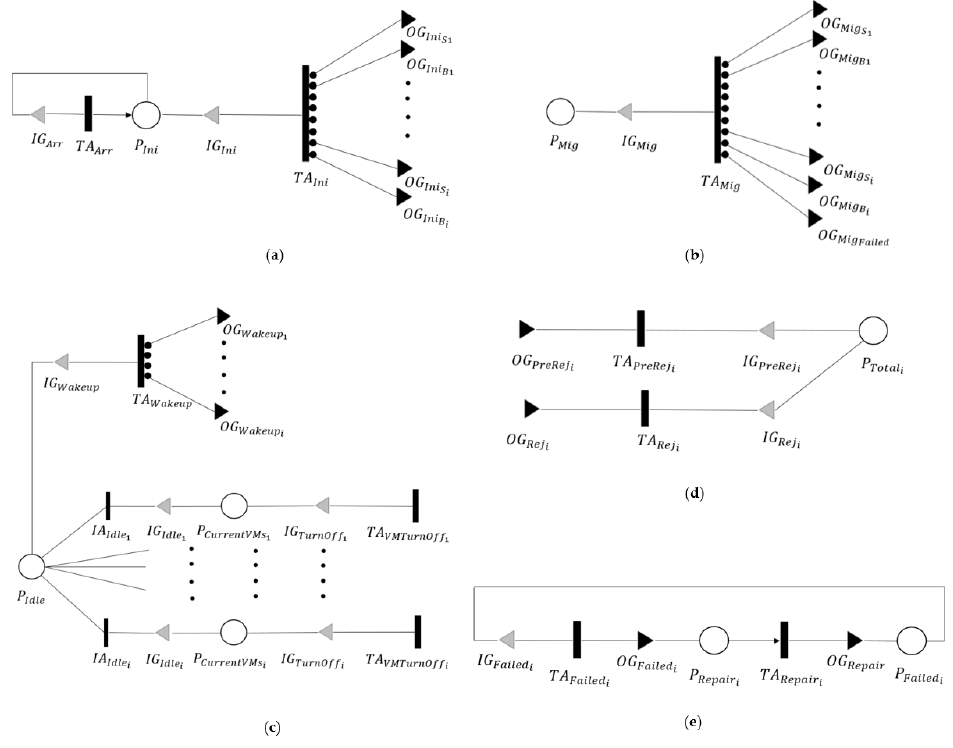
Figure 2. The proposed Stochastic Activity Network (SAN) for ( a ) insertion sub-model, ( b ) migration sub-model, ( c ) service and green computing sub-model, ( d ) rejuvenation sub-model, and ( e ) failure sub-model. Table 1. Rate of timed activities of the proposed Stochastic Activity Network (SAN)